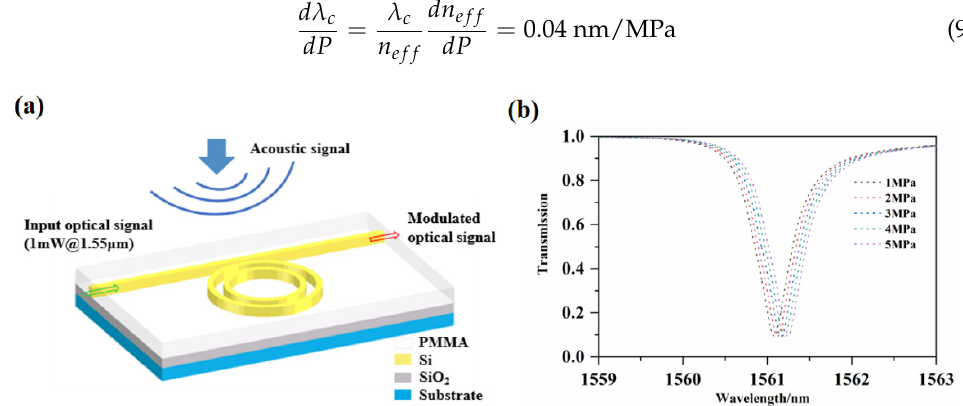
Figure 5. ( a ) Schematic diagram of photoacoustic coupling model and ( b ) spectrum response curve under different sound